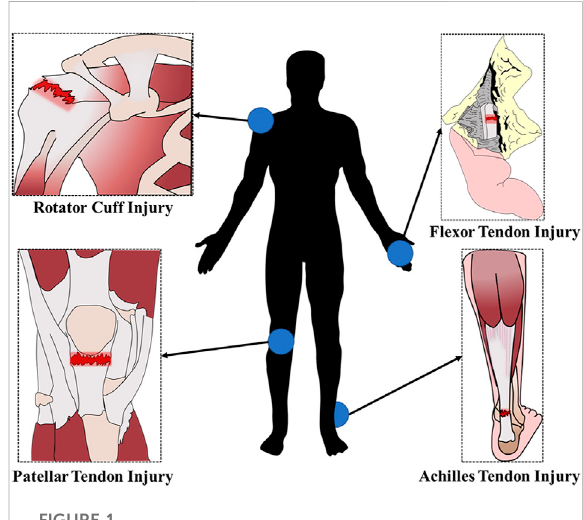
FIGURE 1 Schematic diagram of the sites of tendon injuries that frequently occur in